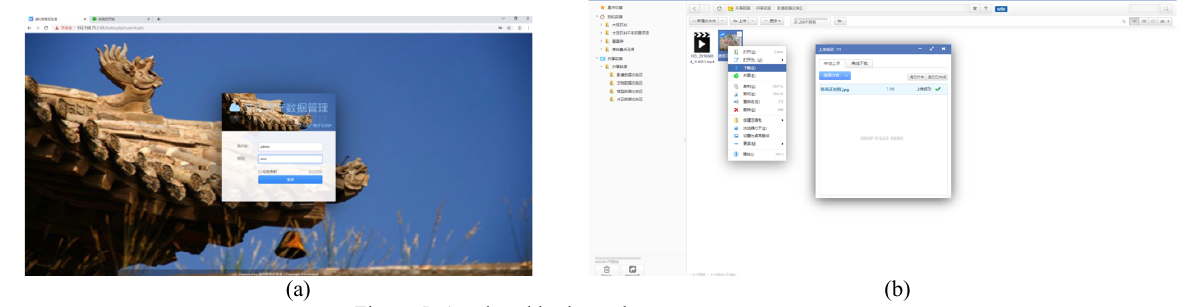
Figure 5. A cultural heritage data management system